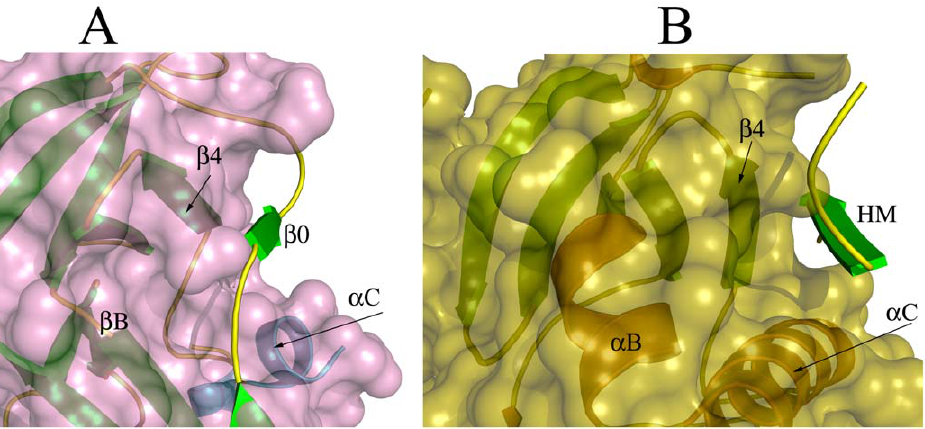
Figure 9. The N-terminal groove. The groove formed in the N-terminal lobe is shown under a semi-transparent surface representation for RSK2 ( A , pink) and for PKB ( B , yellow). ( A ) The deep groove in the N-lobe of RSK2 is formed between the b 4-strand and the a C-helix and is occupied by the N-terminal b 0-strand. Secondary elements of the NTD RSK2 are shown in green and blue. ( B ) The N-lobe pocket in PKB is formed between the b 4- strand and the a C-helix. Secondary elements of the PKB (PDB code 1O6K) are shown in green and yellow. The C-terminal hydrophobic motif (HM) is located in the groove on the N-terminal lobe.